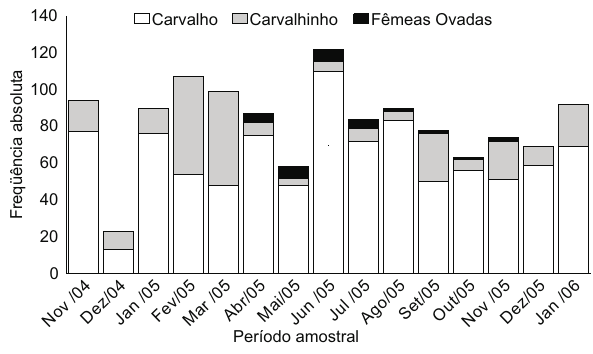
Figura 1. Variação anual da abundância na população de A. schmitti , ao longo do período amostral nos Mananciais da Serra.